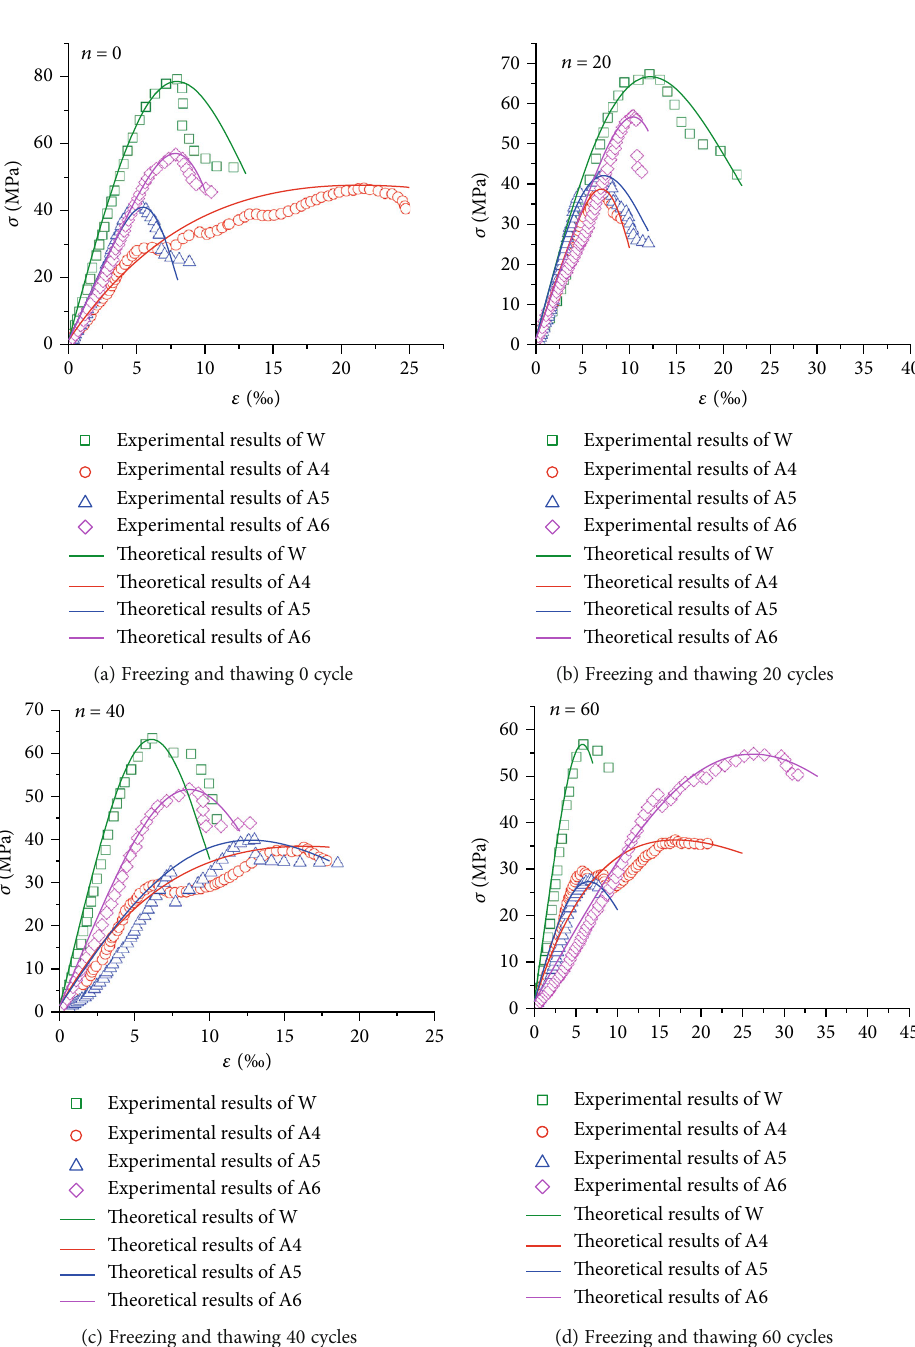
Figure 7: The conventional triaxial compression experimental data of rocks con fi ned by 6 MPa under freezing and thawing cycle